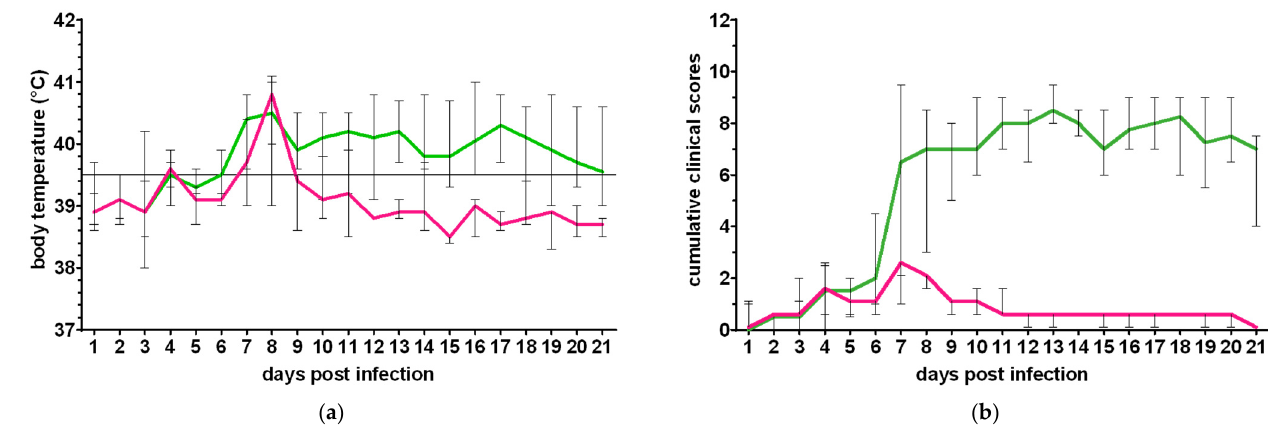
Figure 4. Median (min-max) body temperatures ( a ) and cumulative clinical scores ( b ) of clinically (green) versus subclinically (purple) infected animals.